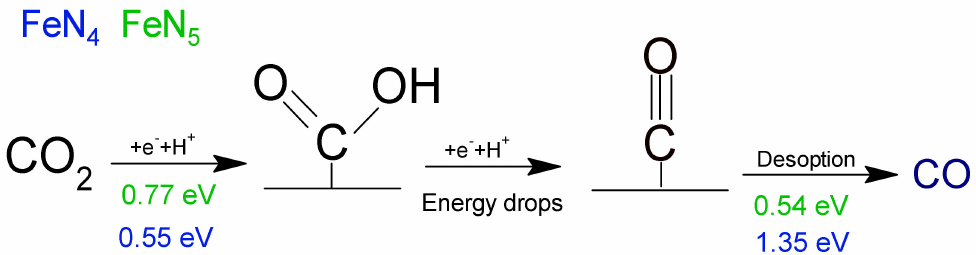
Figure 18. Reaction mechanism of the electroreduction of CO 2 to CO and binding force with intermediaries COOH*, CO* on FeN 4 and FeN 5 active